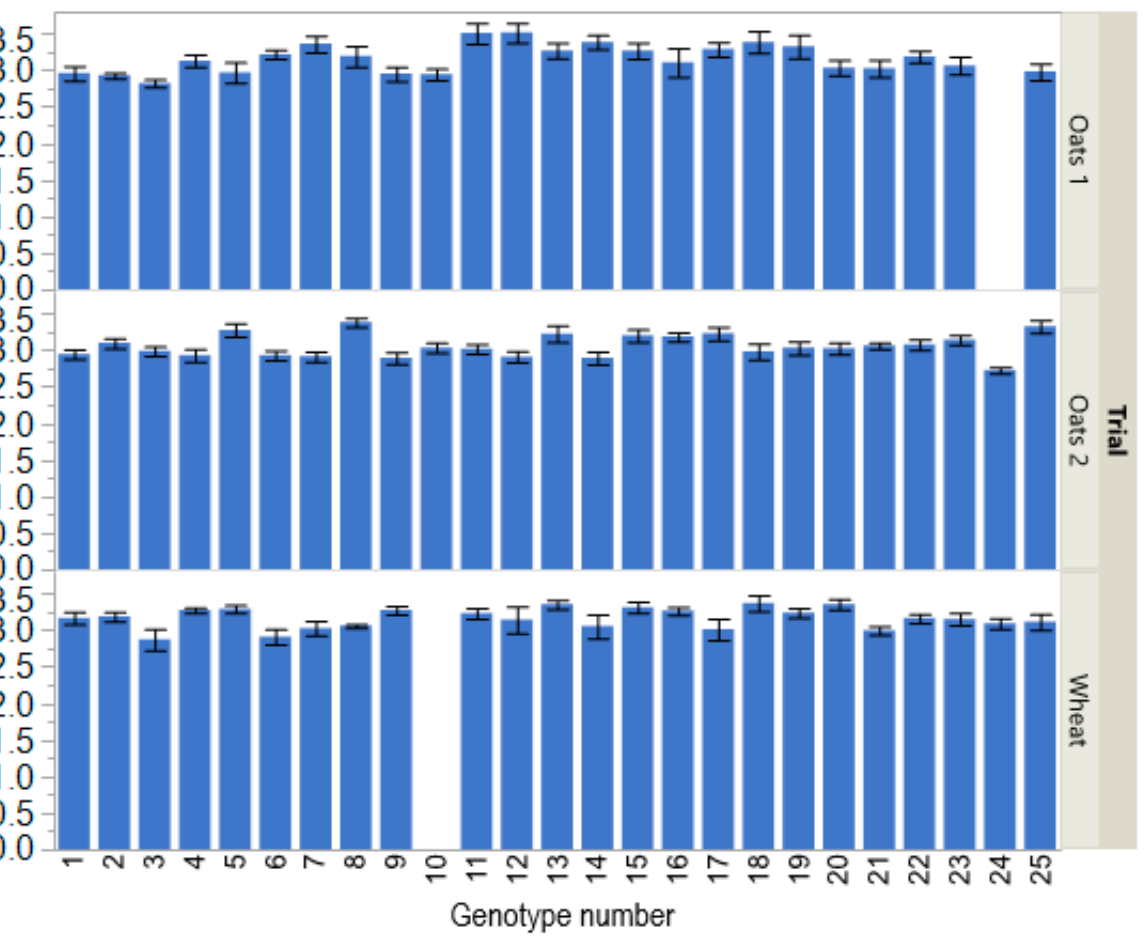
Figure 1. Gas production at 24 h of incubation ( P 24 ) of straw from different oats and wheat genotypes from three breeding trials (Oats 1, advanced breeding lines and commercial varieties; Oats 2, commercial and historical varieties; Wheat, advanced breeding lines and commercial varieties) in in vitro rumen cultures. Each error bar is constructed using one standard error of the mean.